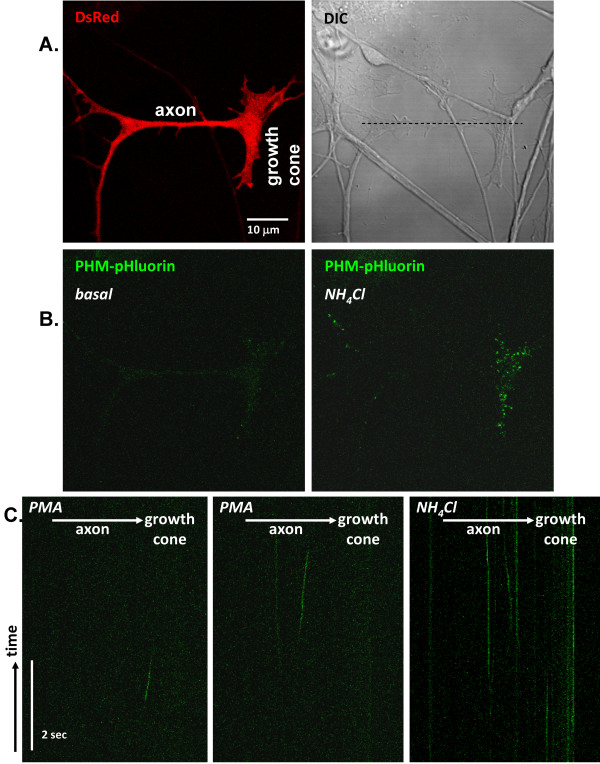
Fusion events are detected by increases in PHM-pHluorin fluorescence. Neurons were co-transfected with vectors encoding PHM-pHluorin and DsRed. All images in this figure are from a single microscope field of one neuron; four other neurons yielded similar results. After 2 days in culture, growth cones of neurons expressing DsRed were identified, and image frames were acquired under basal conditions (A, top left). A horizontally oriented line was placed through the center of the axon and growth cone. Scans were acquired continuously along the indicated line during PMA stimulation; two examples are shown (C, left and middle). Distance in the x dimension is represented on the x-axis, with the cell soma out of the picture to the left and the growth cone to the right. Time is represented on the y-axis; the total time for each image displayed is 6 sec. At the conclusion of the experiment, the total LDCV population was visualized by adding 5 mM NH4Cl to the bath solution; a frame (B, right) and line scan (C, right) are shown.